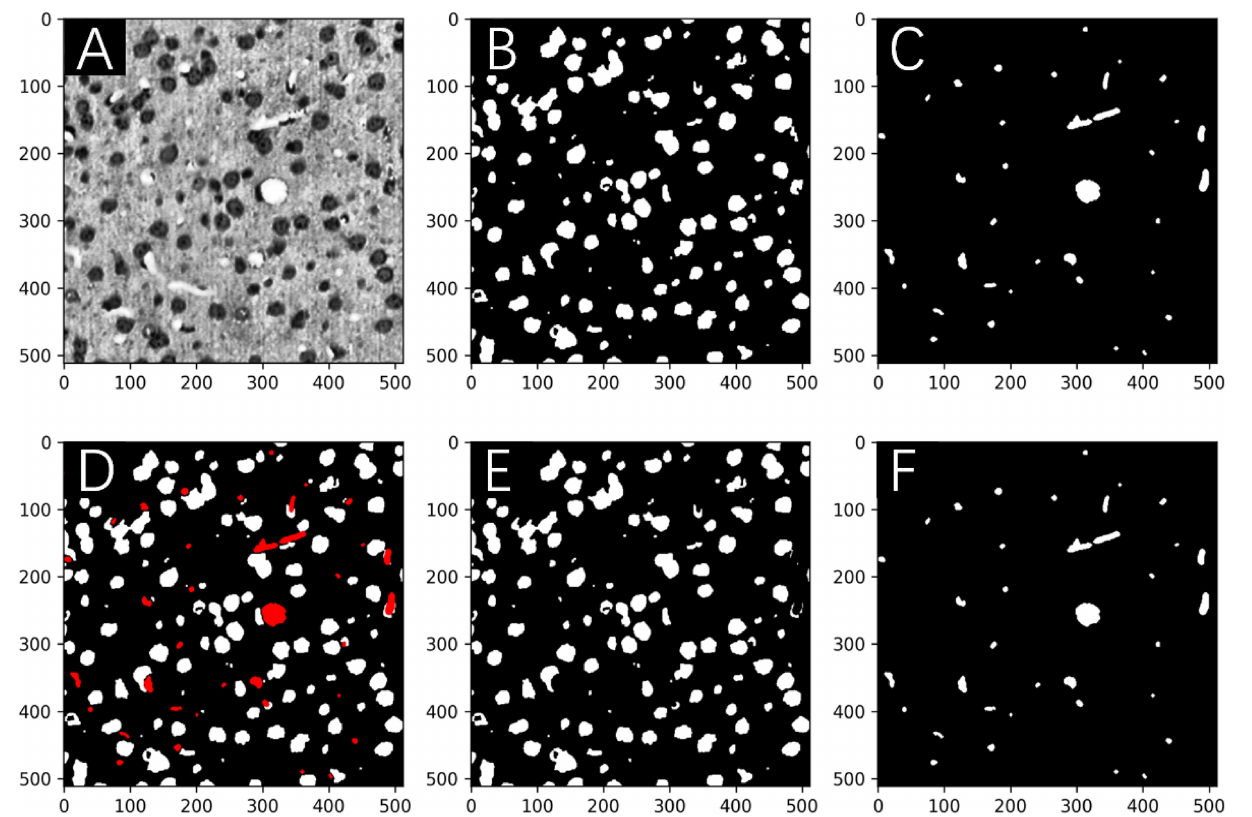
FIGURE 7 | Network predictions vs . human annotations for a MOST 2D image in the gold standard set in the boosting framework after 10 iterations. Image (A) is labeled for somata (B) and vessels (C) and then predicted by the network in panels (E,F) , respectively. The predictions are merged into one image (D) , where the vessels are shown in red. The DC for the segmentation of somata and vessels was 0.994 and 0.963,